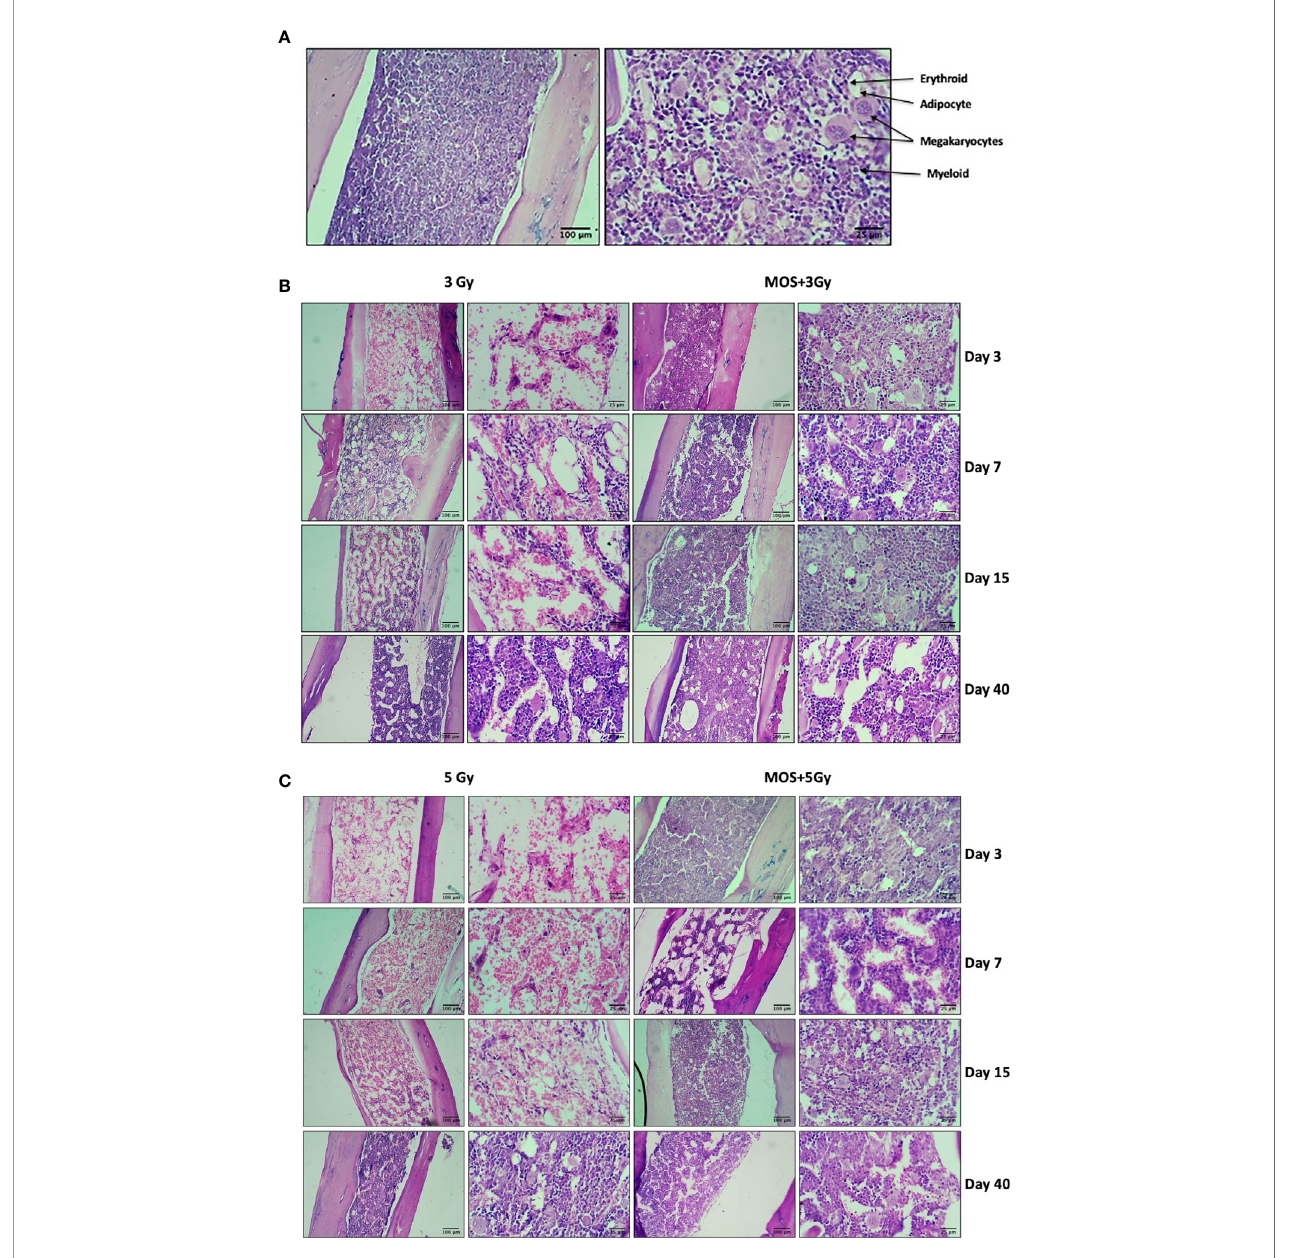
FIGURE 3 | Histological examination of bone marrow. Mice were treated with MOS and/or subjected to TBI (3 and 5 Gy) and assessed for histological examination of small intestine on days 3, 7, 15, and 40-post MOS treatment and/or TBI as described in Materials and Methods . (A) Representative image of H&E stained femur section of un-irradiated control mice. (B) Representative image of H&E stained femur section of 3 Gy TBI and 3 Gy +M mice. (C) Representative image of H&E stained femur section of 5 Gy TBI and 5 Gy +M